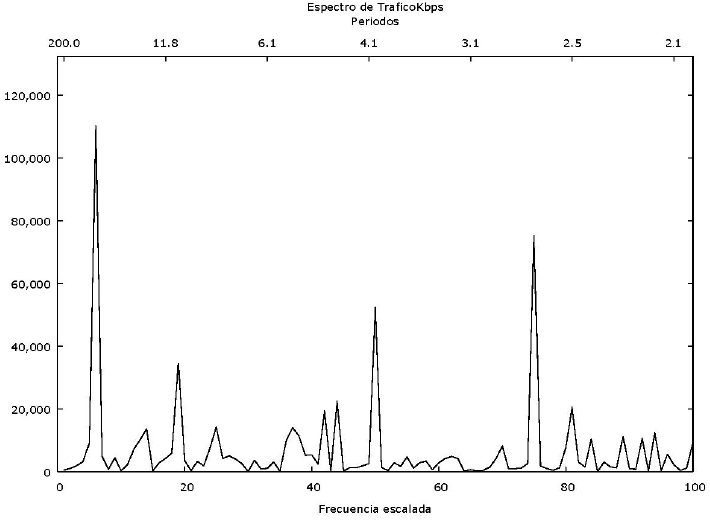
Figure 5. PERIODOGRAM of the original series .